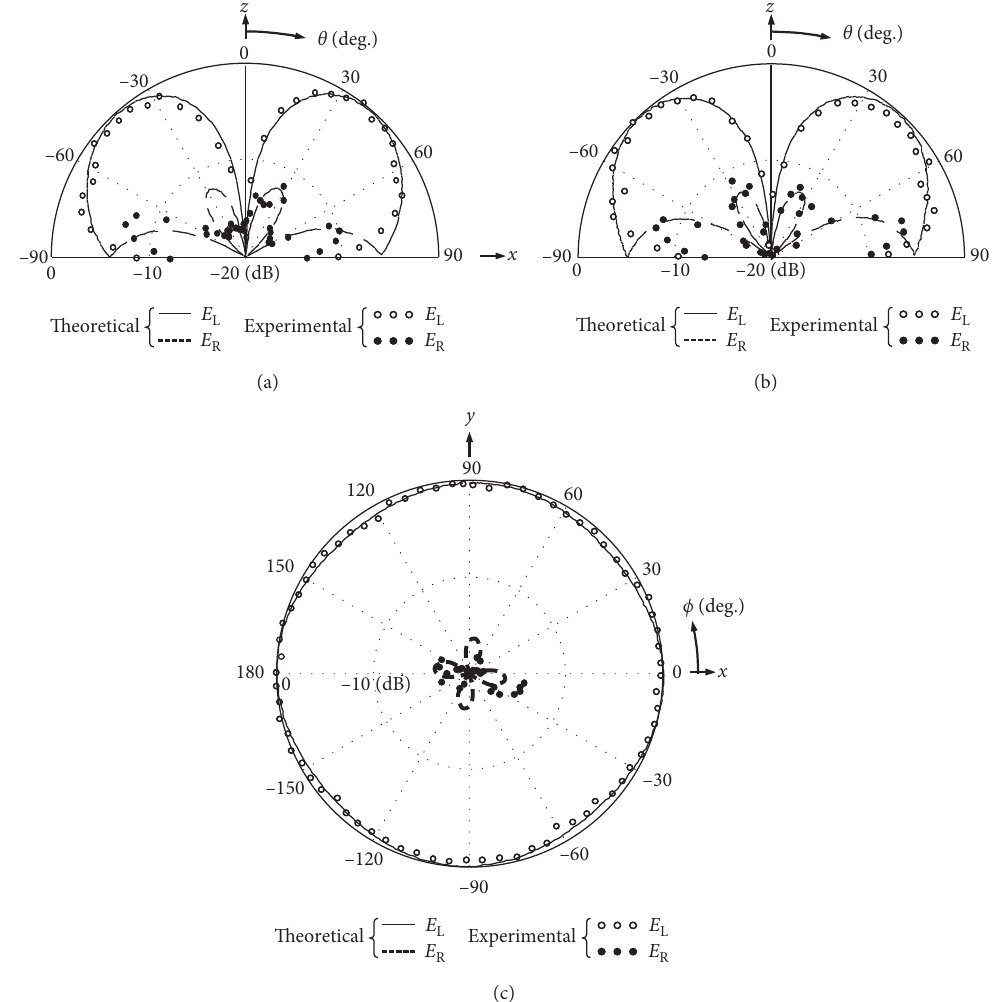
� (57 λ � 1.0 f � 0 ° plane, where the beam direction x , d y ) 0 /256, 15 λ 0 /256) at f 0 . (a) ϕ